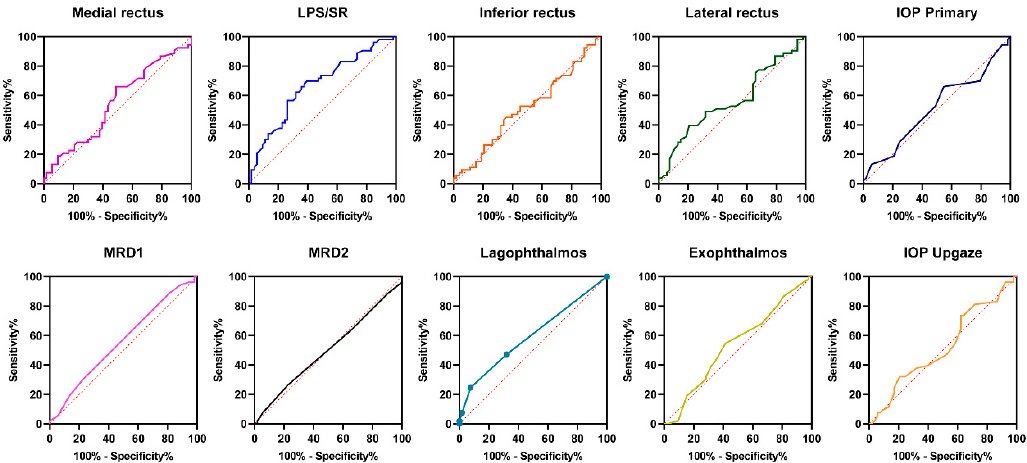
Figure 3. Receiver operating characteristic (ROC) curve analysis showing the area under the curve (AUC) of the diagnostic confidence for different parameters. IOP, intraocular pressure; MRD1, margin reflex distance to the upper eyelid; MRD2, margin reflex distance to the lower eyelid; LPS/SR, levator palpebrae superioris–superior rectus complex.